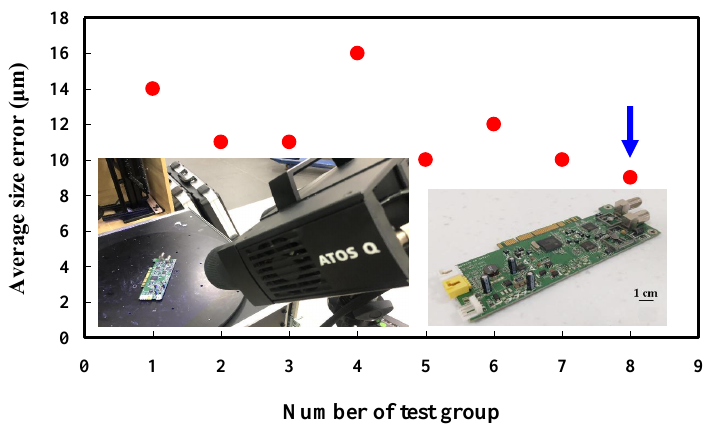
Figure 19. Average size error of the eight test groups compared to conventional method for the circuit board.